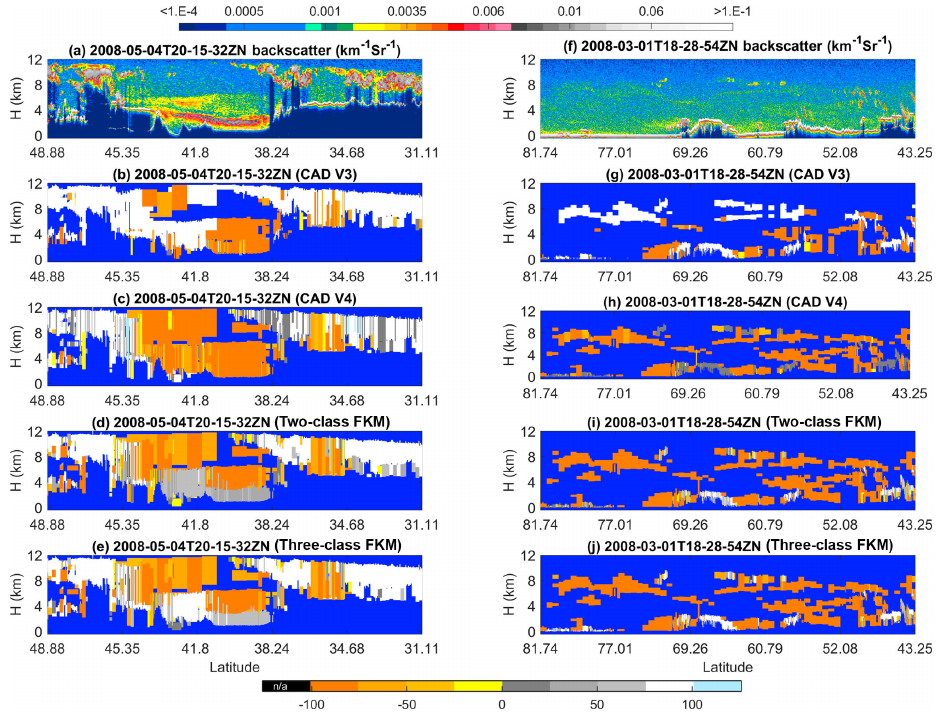
Figure 8. The top row shows 532nm attenuated backscatter coefficients for (a) dust in the Taklamakan basin on 4 May 2008 and (f) lofted Asian dust being transported into the Arctic on 1 March 2008. The rows below show the CAD results reported by four different algorithms: COCA V3 (b, g) , COCA V4 (c, h) , the two-class CAD FKM (d, i) , and the three-class CAD FKM (e, j)